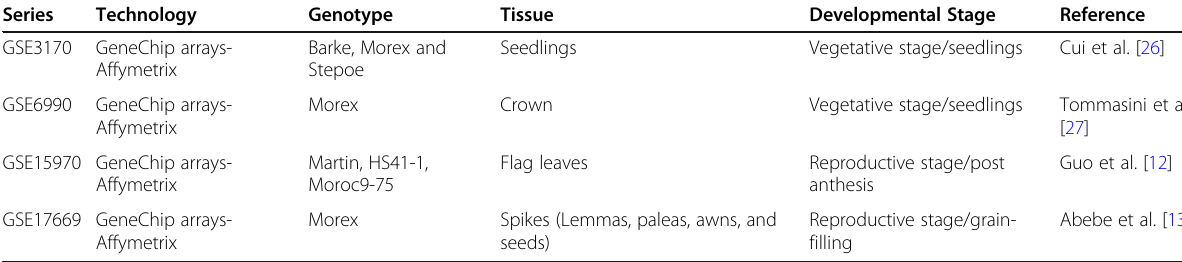
Table 1 The microarray data series used in this